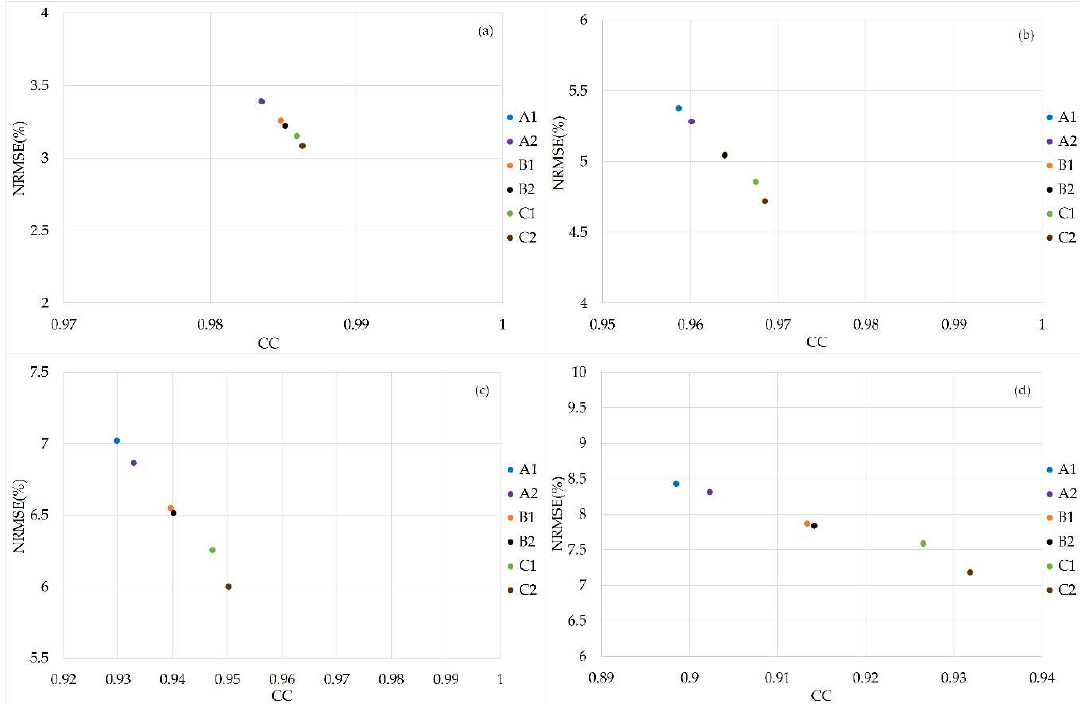
Figure 8. TC intensity predictions with ( a ) 6 h lead time; ( b ) 12 h lead time; ( c ) 18 h lead time; and ( d ) 24 h lead time. The abscissa and the ordinate represent the correlation coefficient and normalized root mean square error, respectively.